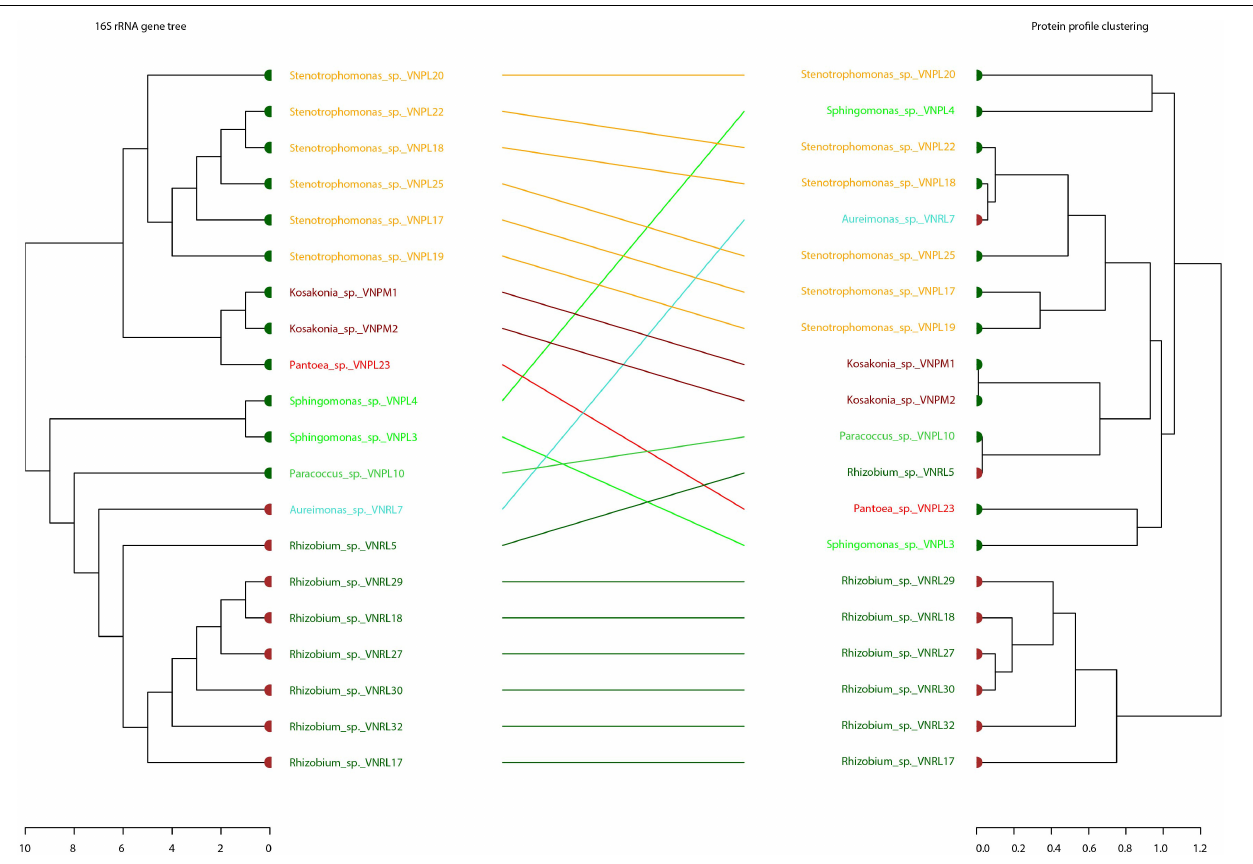
FIGURE 5 | Comparison of the phylogenetic 16S rRNA gene and MALDI bio-typer protein profile clusters: tanglegrams for the phyla Proteobacteria were generated with the R package dendextend and the tool Dendroscope 3 to display the phylogenetic (left) and protein pattern-specific clusters (right) in an aligned style. Colored leaf labels indicate the group species name and taxonomic common affiliation, while the colors of the bold leaf nodes specify the isolation site (green: endophyllosphere, brown: endorhizosphere) to emphasize (dis-) similarities. Indicated names of species are potential/putative, based on partial 16S rRNA gene sequencing, and one should exercise caution in relying on names of